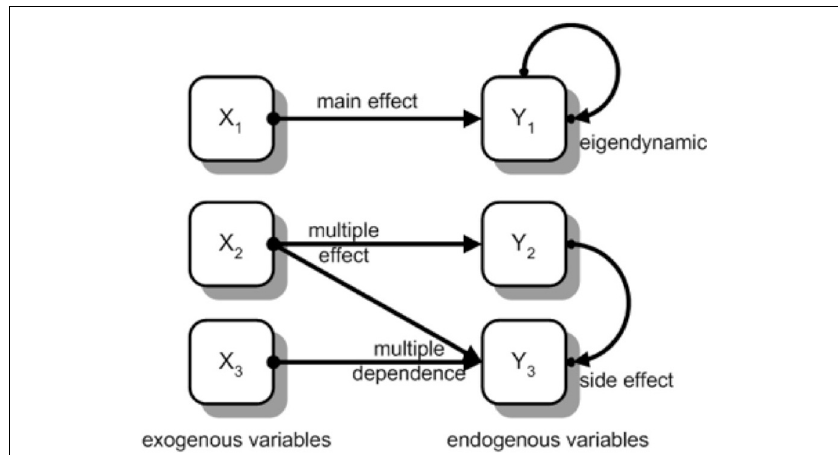
FIGURE 1 | A typical MicroDYN item as an example for a more simple system with different kinds of effects. For the selected sets of endogenous and exogenous variables any cover story is possible (from Greiff et al., 2012, p.